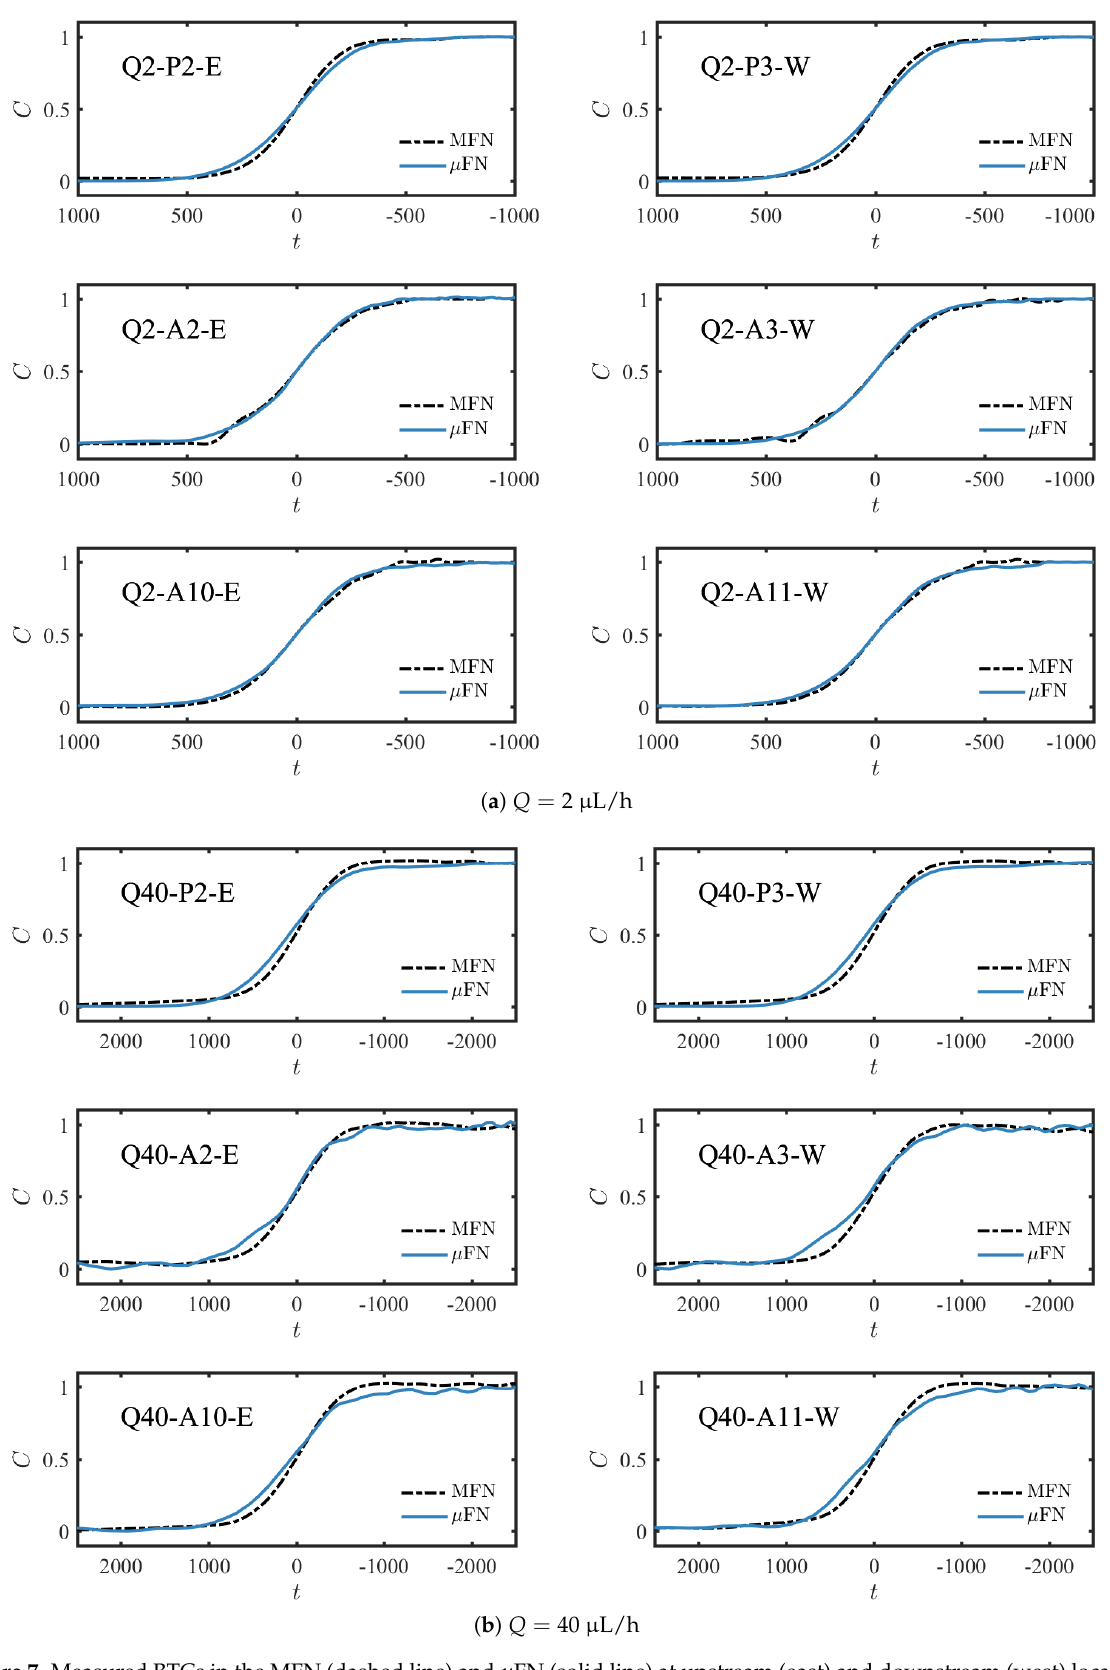
Figure 7. Measured BTCs in the MFN (dashed line) and µ FN (solid line) at upstream (east) and downstream (west) locations on the same primary (P2–P3), secondary (A10–A11) and tertiary (A2–A3) fracture at: ( a ) Q = 2 µ L/h; and ( b ) Q = 40 µ